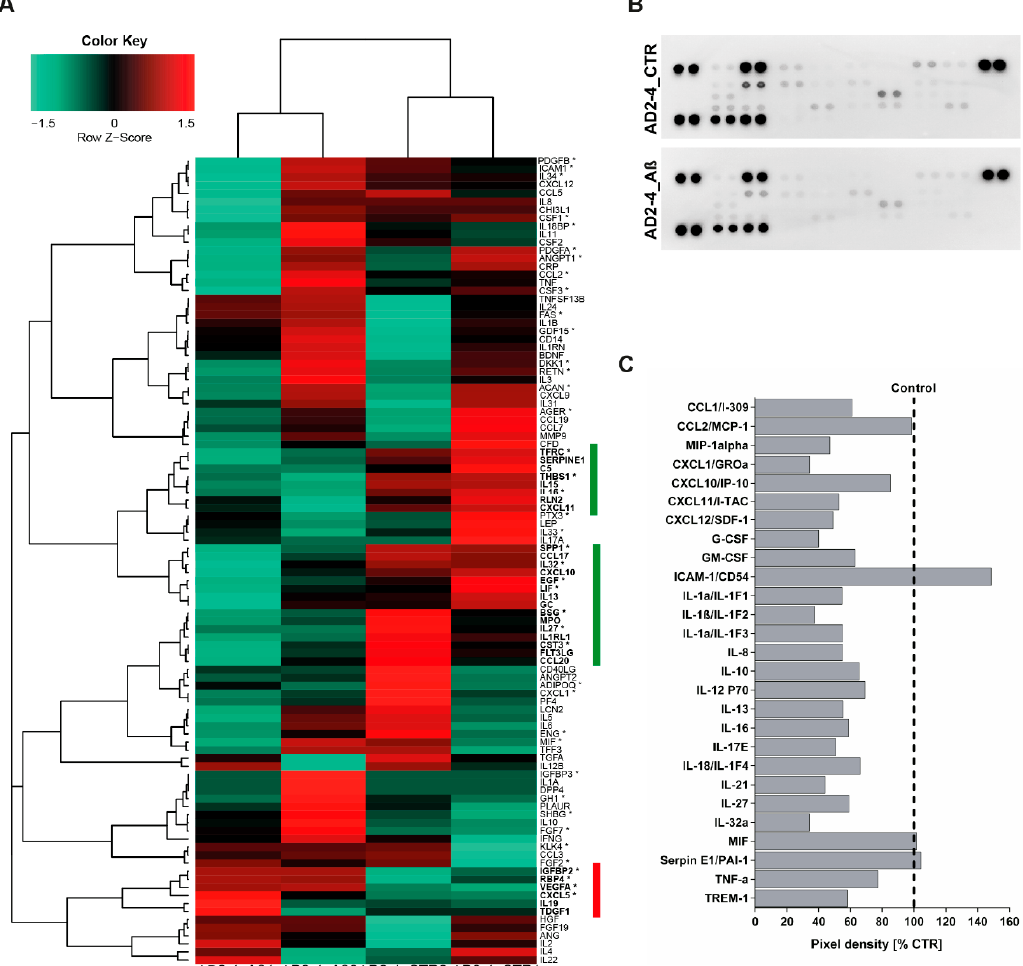
Figure 6. Analysis of cytokine expression and secreted factors in AD neuronal cultures upon A β -S8C stimulation. ( A ) Heatmap of Pearson correlation analysis of microarrays data from AD neural di ff erentiation under A β -S8C stimulation (AD2-4_ A β 1 and AD2-4_ A β 2) or control (AD2-4_ CTR1 and AD2-4_ CTR2) showing the di ff erential expression of cytokines. The highlighted genes in green represent a cluster of cytokines downregulated upon A β -S8C stimulation whereas the highlighted genes in red represent an upregulated cluster of cytokines. ( B ) Human cytokine array showing the e ff ect of the A β -S8C peptide on the secreted factors of neuronal cultures from pooled AD2-2 and AD2-4 culture supernatants of control condition and 72 h of A β -S8C stimulation. ( C ) Quantitative analysis of the secreted factors shows that A β -S8C treatment decreases the amount of secreted cytokines in AD neuronal